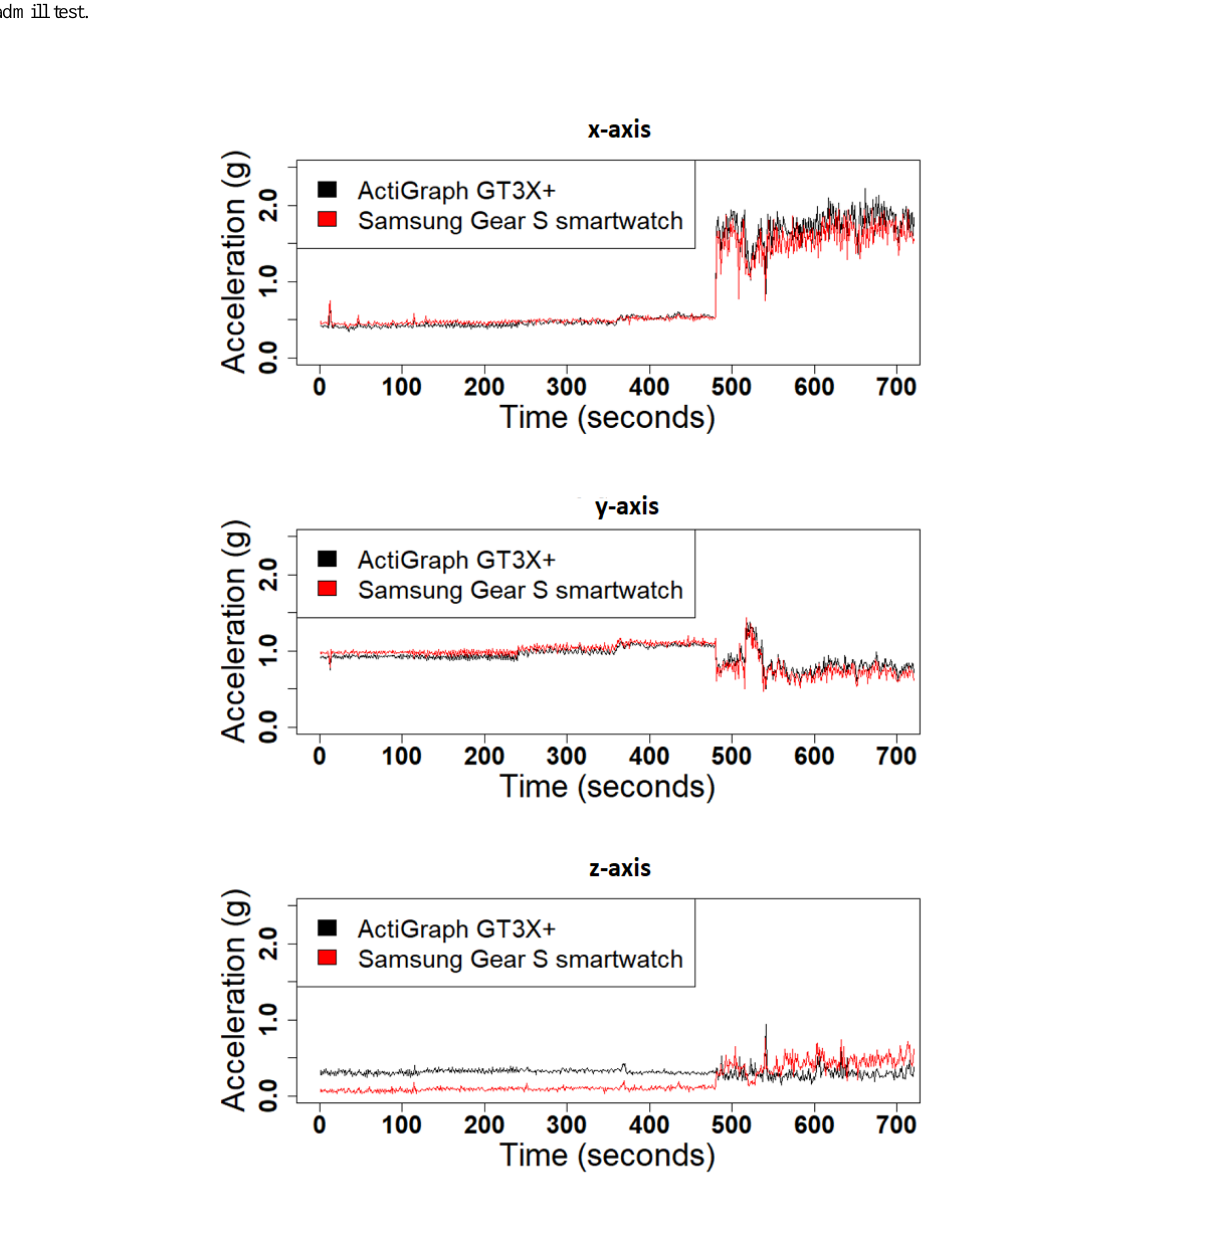
Figure 5. The 1-second root mean square of the acceleration data from Samsung Gear S smartwatch and ActiGraph GT3X+ for each axis for the treadmill